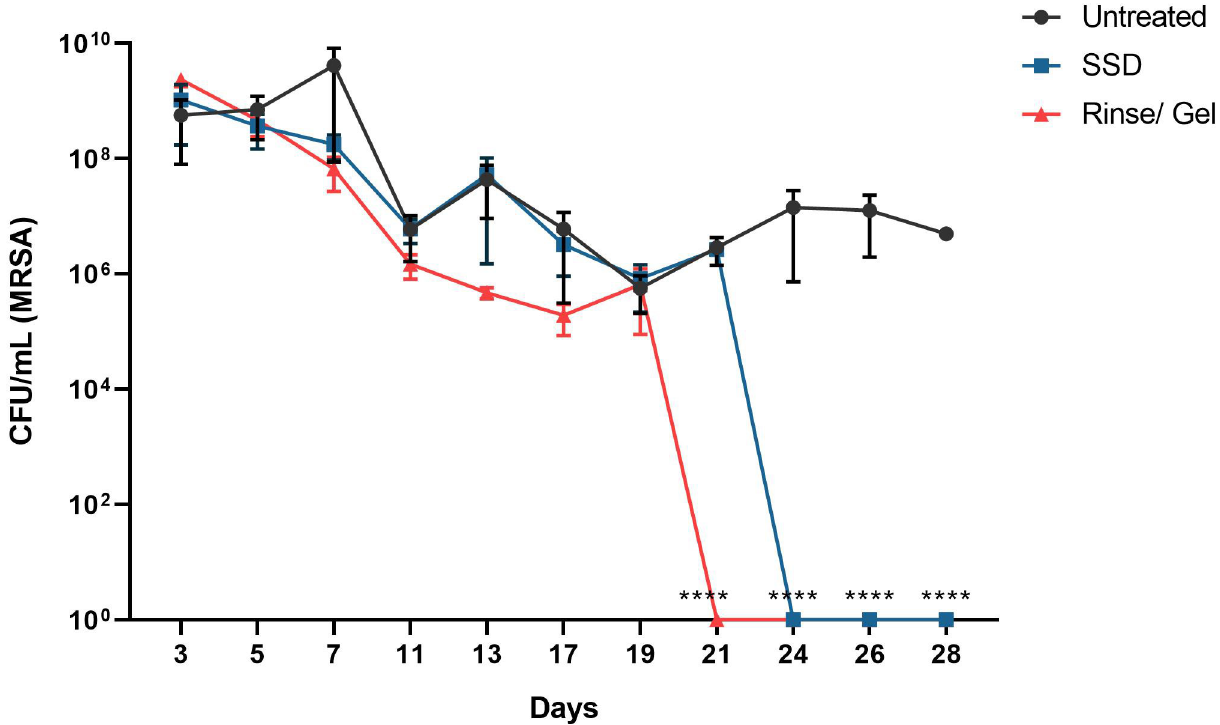
Fig 4. The wound rinse and wound gel treatment resulted in significant reduction of bioburden in MRSA infected PTBWs. Treatment with the wound rinse/ gel led to complete eradication of viable bacteria in PTBWs within 21 days of treatment compared to silver sulfadiazine (SSD) and untreated controls (P < 0.0001). Data represented as the mean CFU/ml +/- SEM. ���� , P <